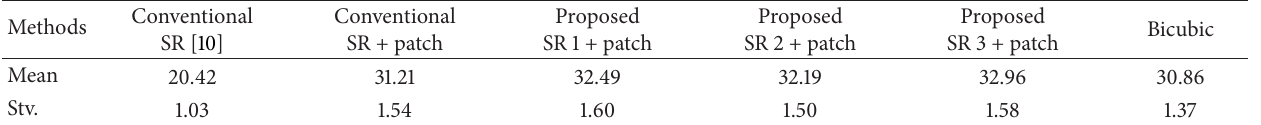
Table 2: Comparison of the averaged PSNR for a nonaligned face image database